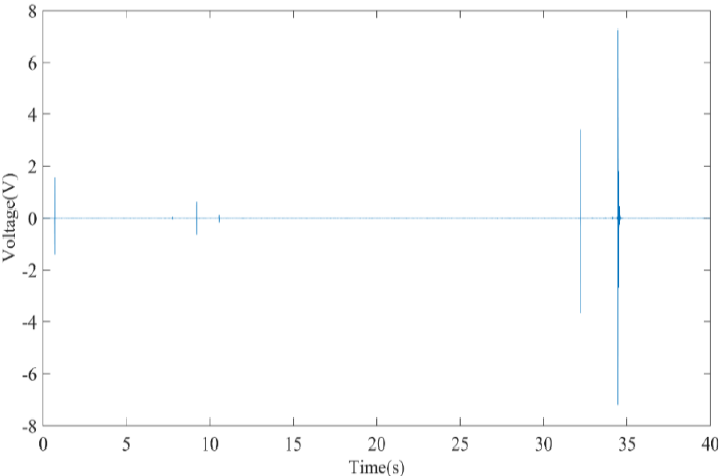
Figure 6. Acquired continuous signal waveform.